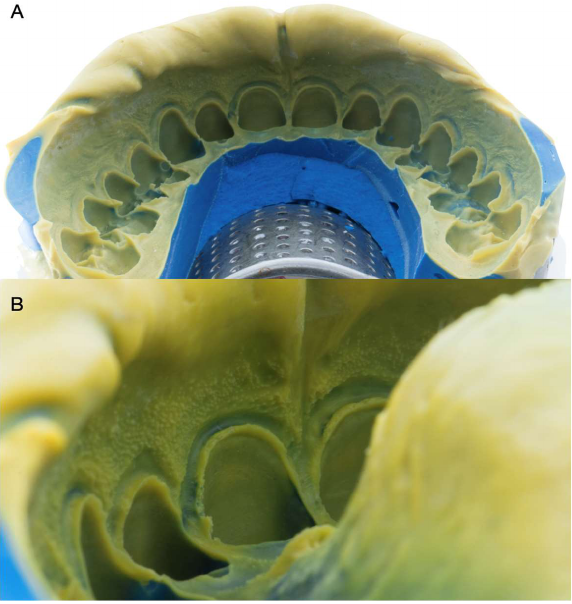
Figure 4. Final impression. ( A ) Maxillary arch impression. ( B ) Impression close-up.